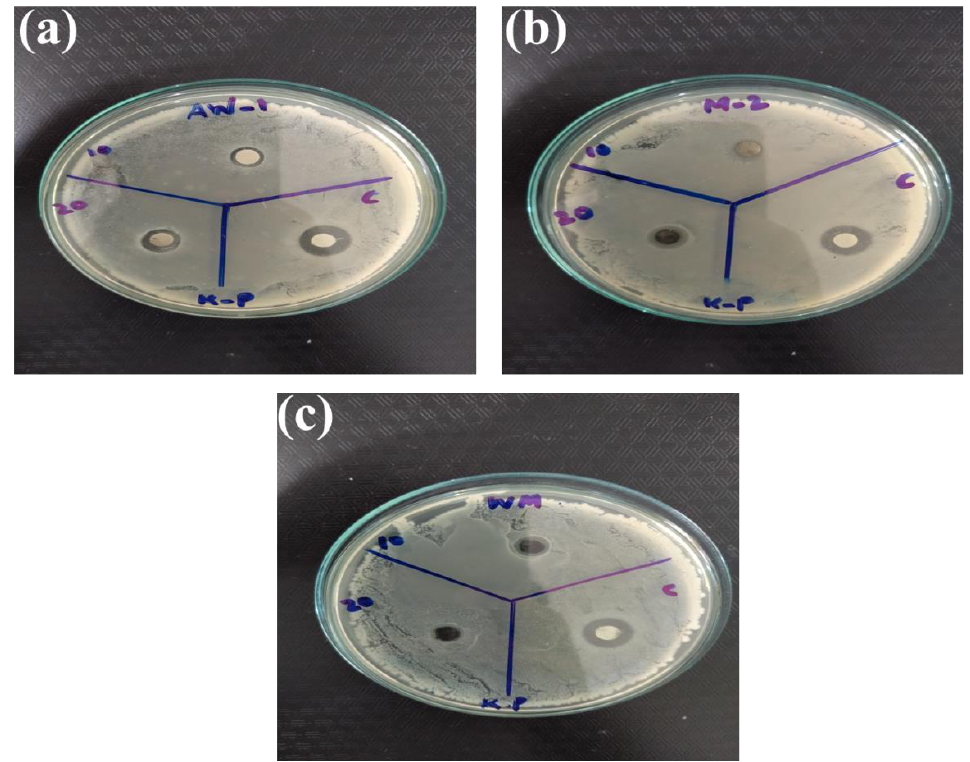
Figure 15. Antibacterial activity of as-prepared material ( a ) WO 3 , ( b ) Mxene and ( c ) WO 3 /Mxene against Klebsiella pneumonia (K. pneumonia ).